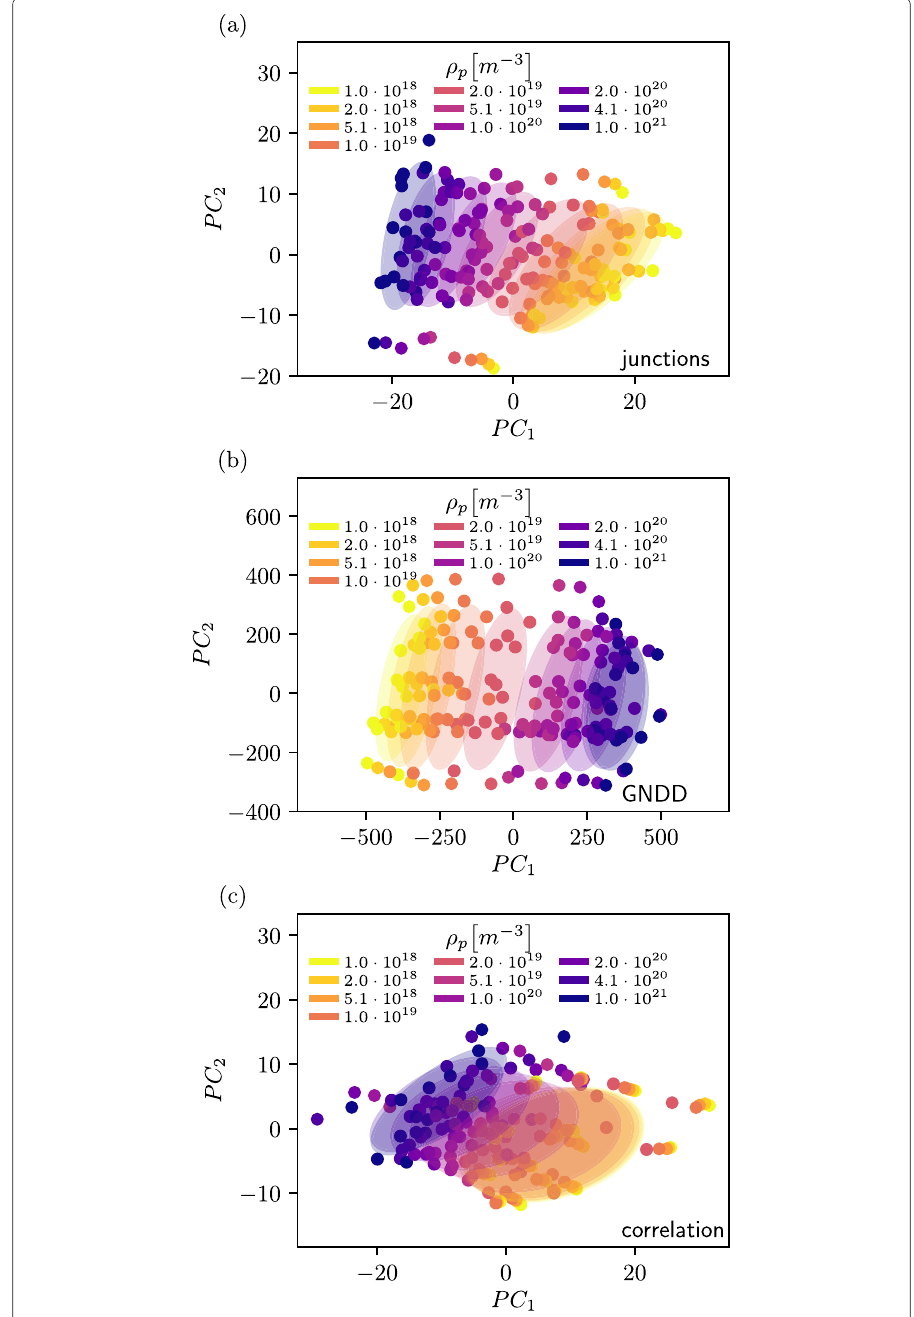
Fig. 4 The systems represented by the two first principal components. The descriptors are a junction lengthening b GND density change and c dislocation correlation collected during the simulation time interval. The coloured regions come from a fit of bivariate normal distribution on the data sets of different ρ p to visualize the differences between them